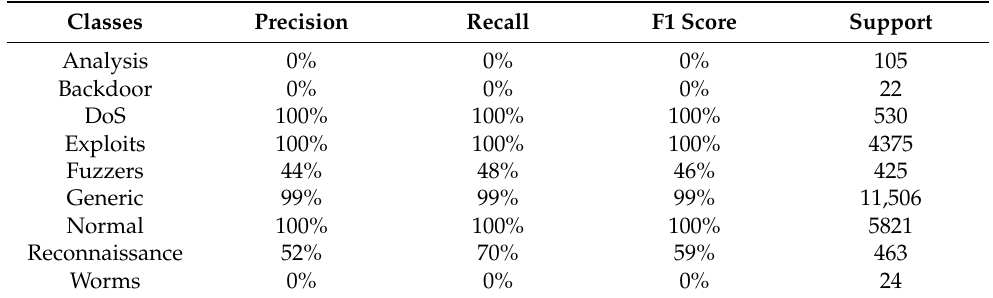
Table 7. Class wise performance evaluation of the tab transformer for multiclass